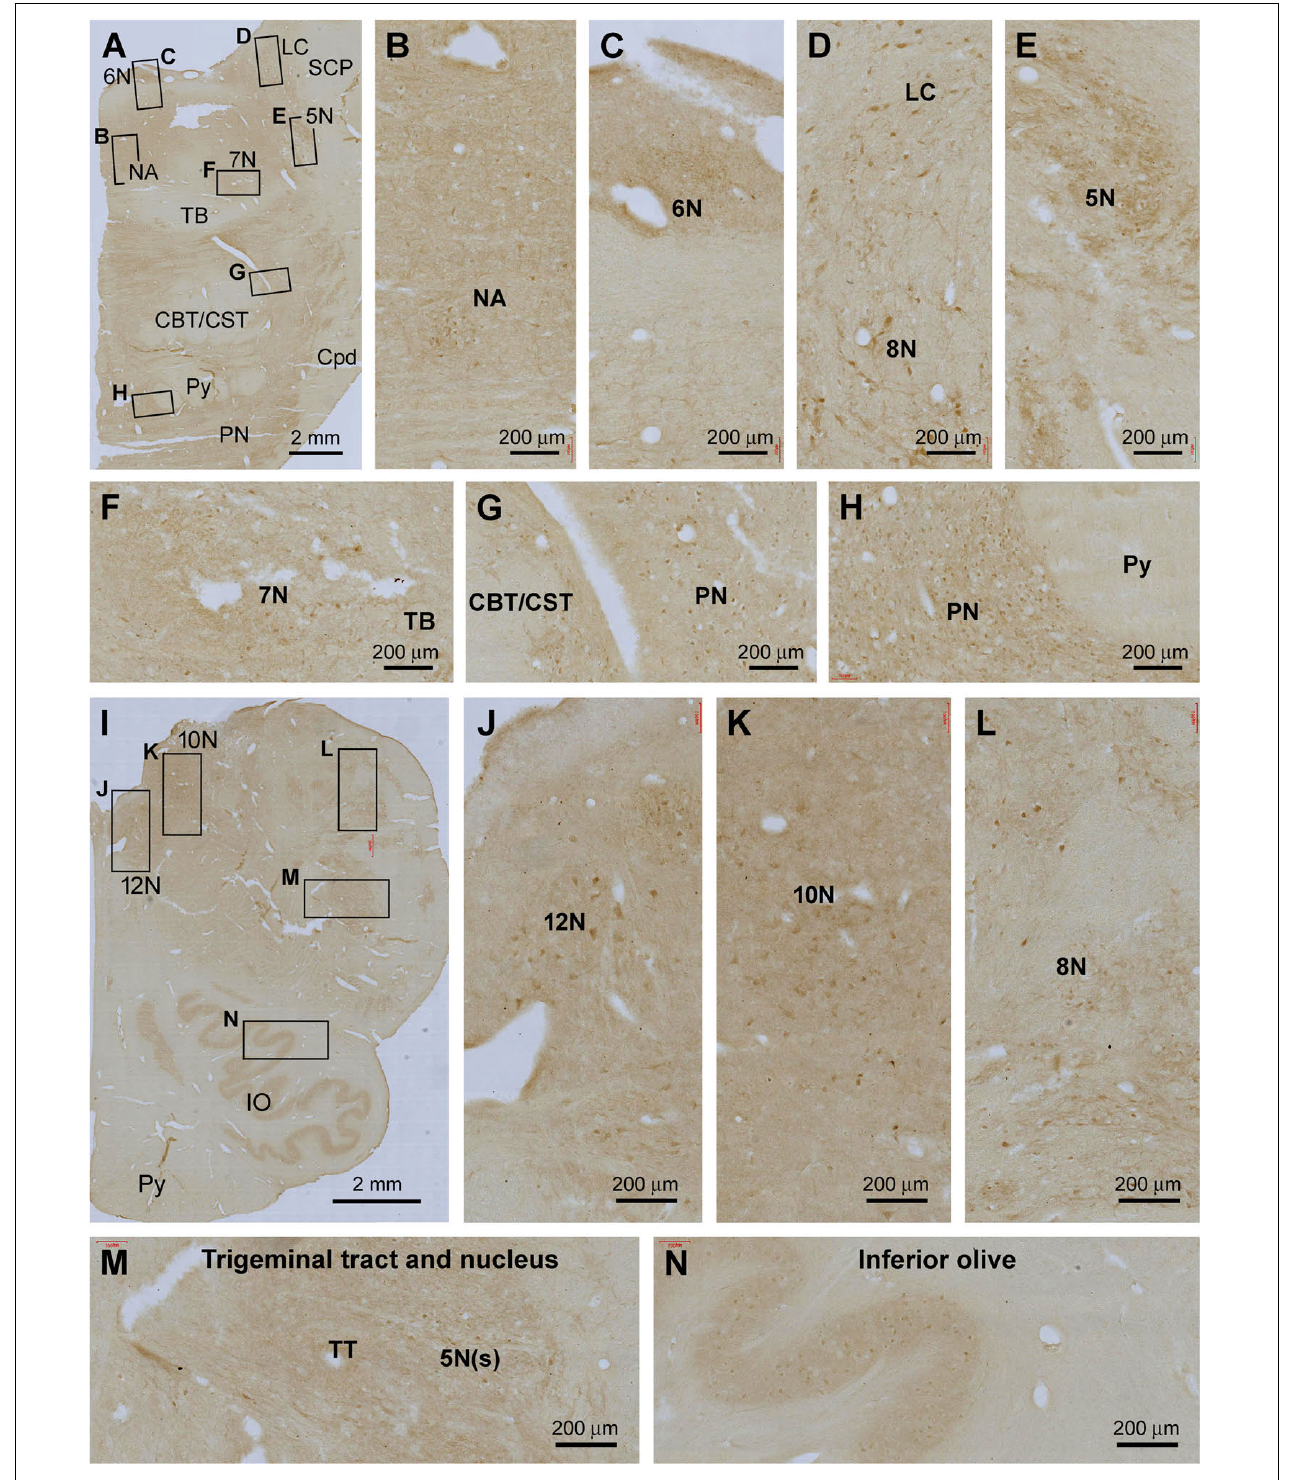
FIGURE 8 | Representative images illustrating Shank3 IR in the pons and medulla oblongata. (A–H) show the low magnification distribution pattern and enlarged views in the subregions of the pons. (I–N) illustrate the overall pattern and local views of the labeling in the medulla oblongata. In general, lightly stained neuropil and neuronal perikarya are seen at most cranial nerve nuclei and specific brainstem nuclei, including the locus coeruleus (LC); inferior olive (IV) and pontine nuclei (PN), while no labeling is seen in neural fiber bundles (B–H,J–N) . 5–12 N, main nuclei of the 5–12 cranial nerves; NA, nucleus ambiguous; SCP, superior cerebellar peduncle; TB, triphorid body; CBT, CST, the corticobulbar and corticospinal tracts; TT, trigeminal tract; Py, pyramidal tract. Scale bars are as indicated in each panel.